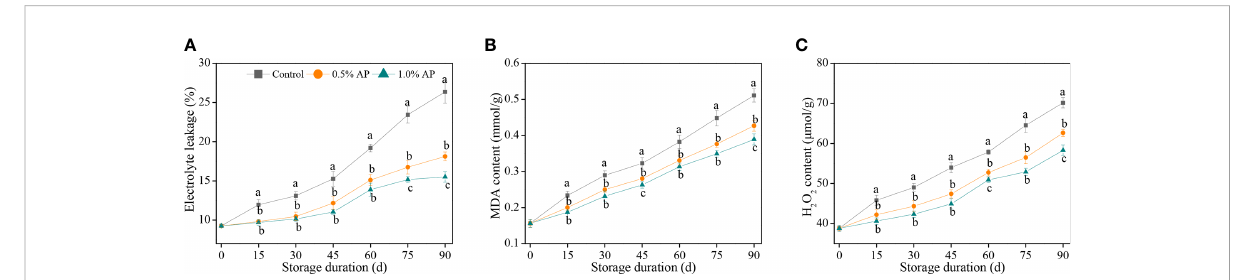
FIGURE 2 Variation in electrolyte leakage (A) , MDA content (B) , and H 2 O 2 content (C) in the juice sac of ‘ Jinshayou ’ pummelo fruit treated without or with AP (0.5% and 1.0%) during room temperature storage period. The different letters for each same sampling point indicate signi fi cantly different at P < 0.05 according to Duncan ’ s multiple range